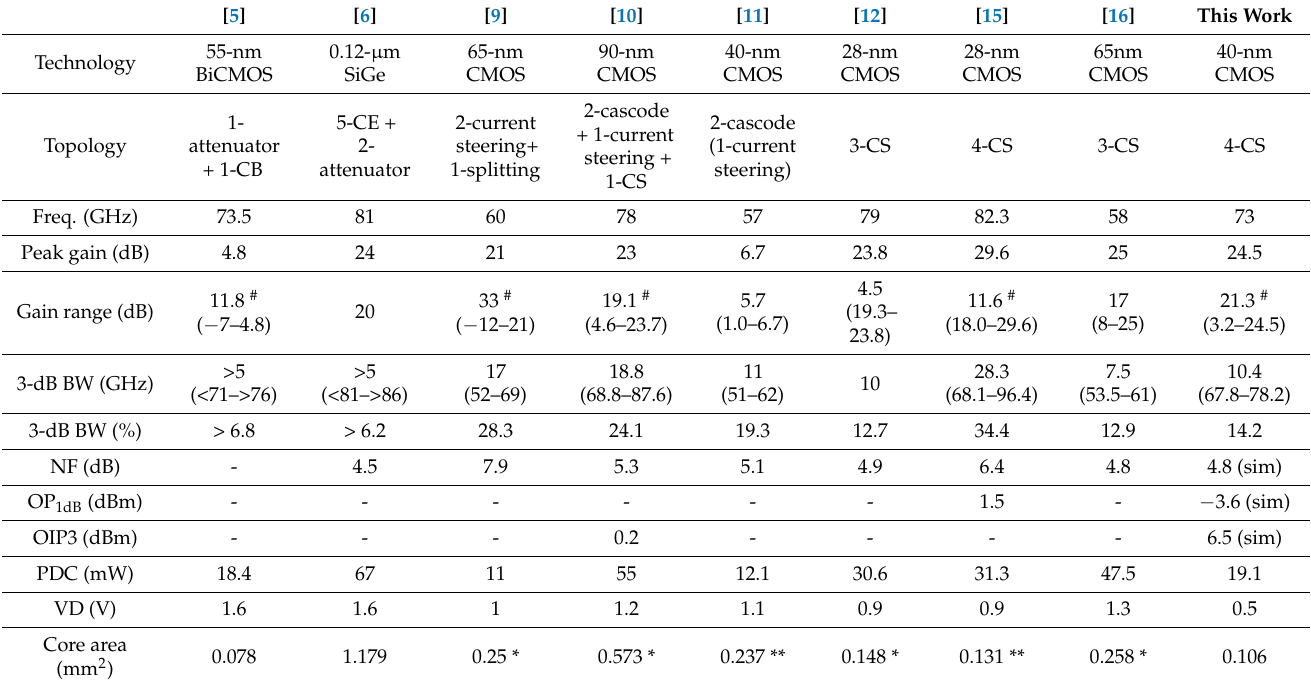
Table 1. Comparison with variable-gain amplifiers (VGAs) in